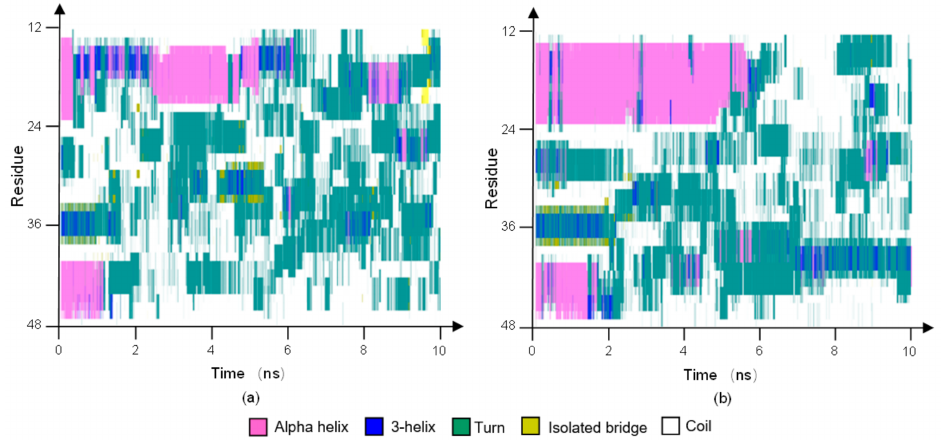
Figure 8. (Color online) Stride evolution of secondary structures of the protein samples ( a ) 1BBL and ( b ) D43N exposed in the oscillating electric field with a frequency of 2000 MHz, respectively.